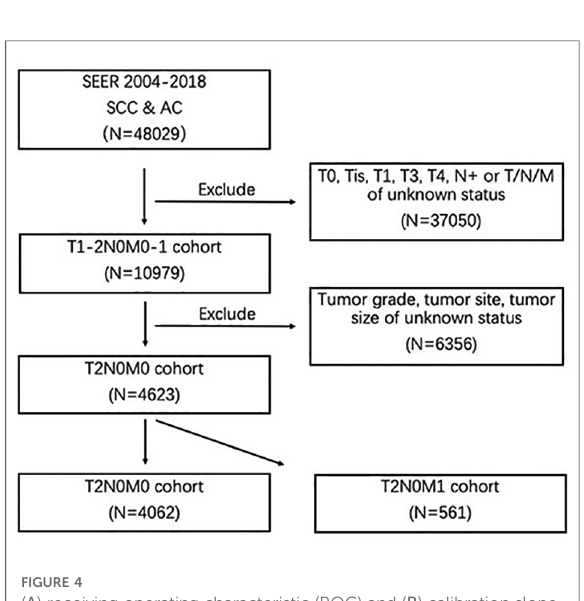
FIGURE 4 ( A ) receiving operating characteristic (ROC) and ( B ) calibration slope curve of our